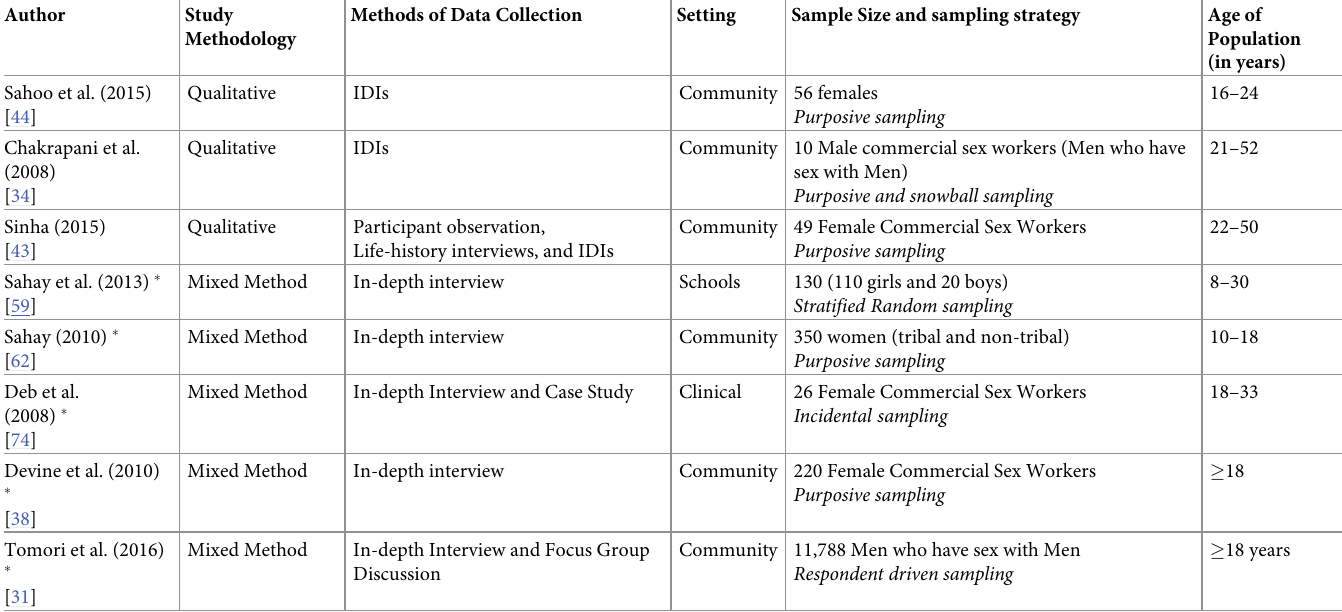
Table 10. Summary of qualitative studies and mixed-methods studies included in the